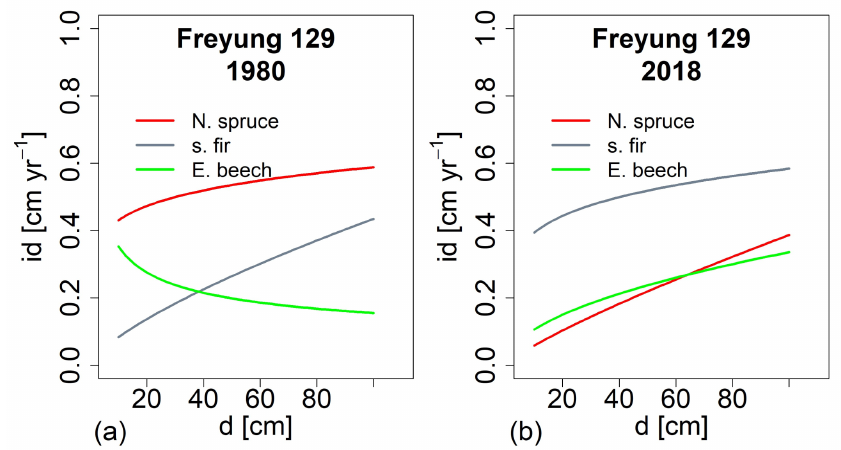
Figure 8. Change of the relationship between stem diameter growth, id , and stem diameter, d , from ( a ) 1980 to ( b ) 2018. The results are shown for Norway spruce, silver fir, and European beech and are based on the subplots 22, 31, and 32 where the standing volume was kept continuously at a high level since the beginning of the survey (see also Model 4, Table 6).